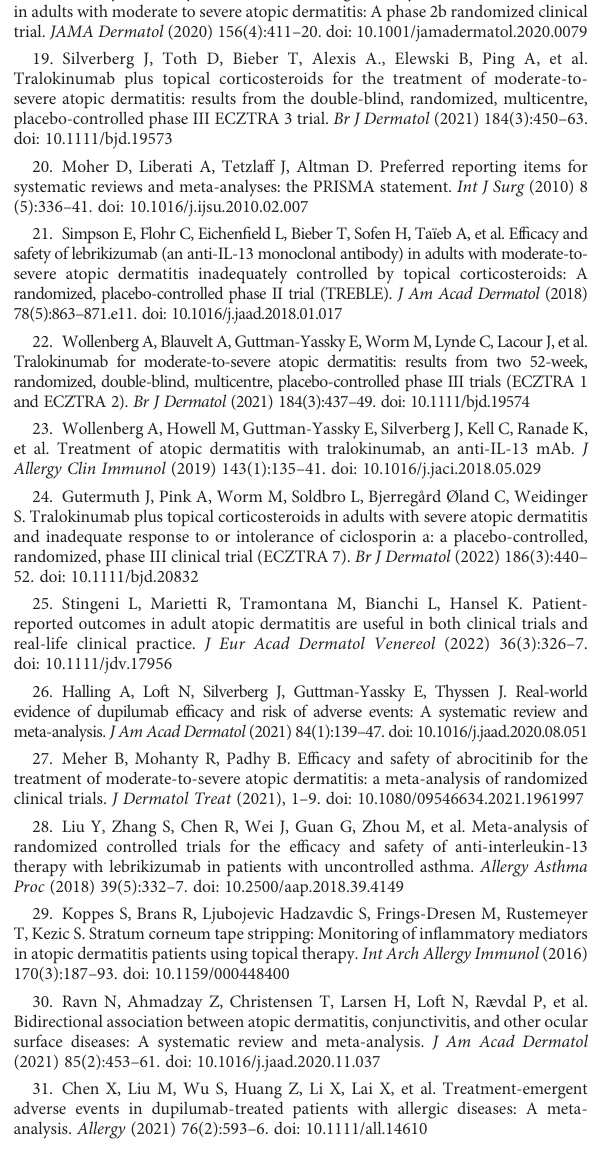
SUPPLEMENTARY FIGURE 2 Forest plot for proportion of patients achieving EASI-75 at the end of antagonizing IL-13 treatment.